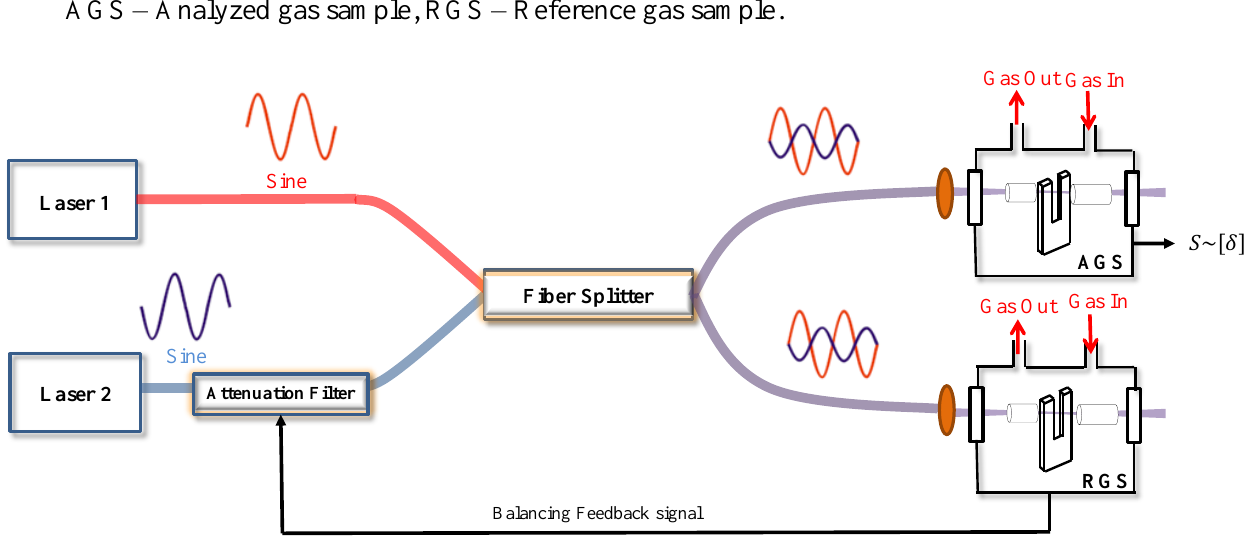
Figure 12. MOCAM setup for isotope concentration ratios and temperature